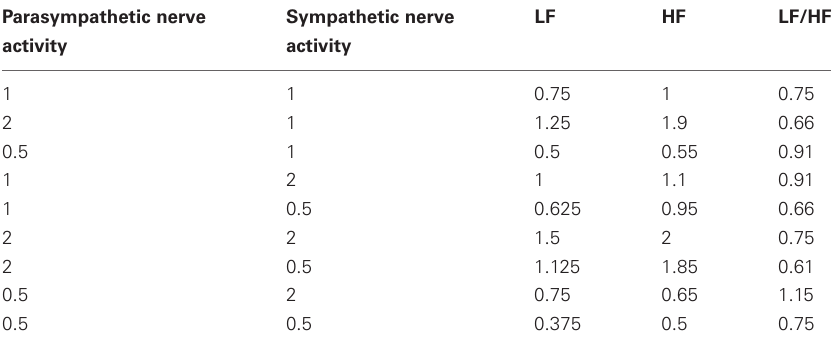
Table 1 | Examples of the effects of varying cardiac sympathetic and parasympathetic nerve activity on LF/HF.